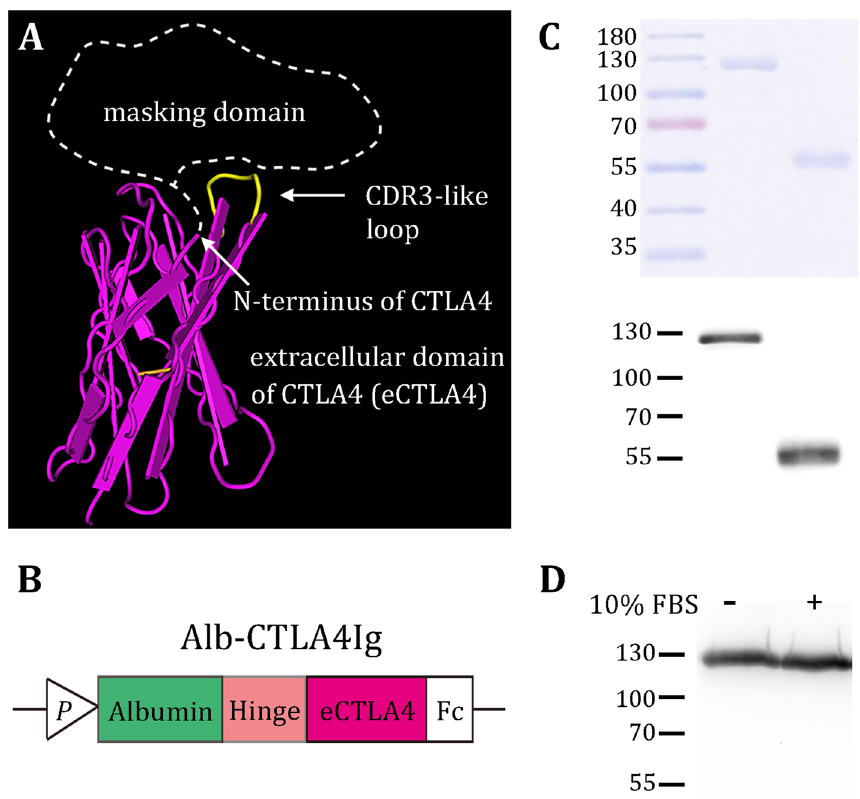
Fig. 2 Design, production, and stability of mAlb‑CTLA4Ig. A Structure of the extracellular domain of mCTLA4 (pink). The CDR3‑like loop is marked in yellow. To block the binding activity, an N‑terminal masking domain (dashed shape) should occupy the space over the CDR3‑like loop. B Schematic representations of mAlb‑CTLA4Ig constructs. eCTLA4, extracellular domain of CTLA4; P, promoter in the expression vector. C Reducing SDS‑PAGE (upper panel) and western blot (lower panel, detected by an anti‑mouse Fcγ antibody) analyses of mAlb‑CTLA4Ig (left lane) and mCTLA4Ig (right lane) purified from ExpiCHO cells transfected with the expression vectors. D The stability of Alb‑CTLA4Ig in DMEM containing 10% fetal bovine sera for 7 days, analyzed by western blot using an anti‑mouse Fcγ